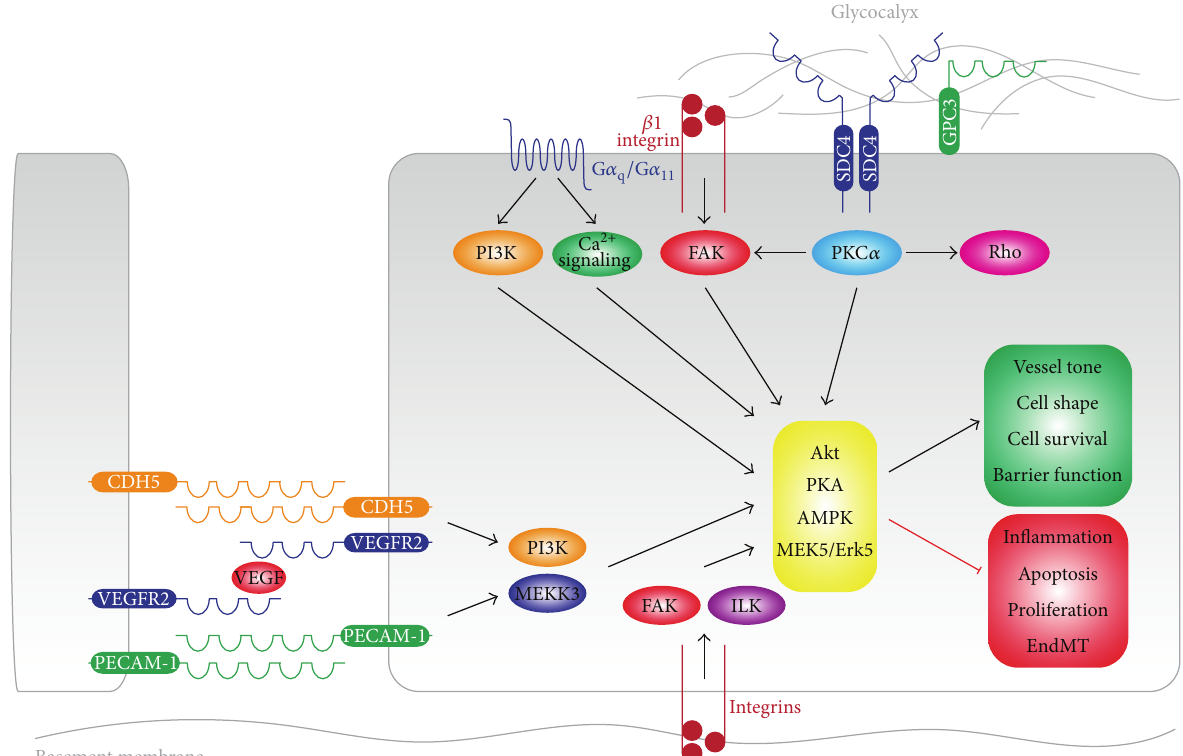
Figure 2: Endothelial shear stress sensing. Endothelial cells sense LSS through a number of mechanisms. Shear stress sensing through the endothelial glycocalyx is mediated by the syndecans and glypicans, which activate PKC signaling. Luminal 𝛽 1-integrins also anchor to the endothelial glycocalyx and activate focal adhesion kinase (FAK). The G-protein-coupled receptors of G 𝛼 q /G 𝛼 11 sense shear stress and activate downstream PI3K and Ca 2+ signaling. The junctional mechanosensory complex consisting of PECAM-1, VEGFR2, and VE-Cadherin mediates PI3K and MAPK (MEKK3) signaling. Signaling through these mechanosensors culminates in activation of Akt, PKA, AMPK, and MEK5/Erk5 which collectively maintain the endothelial